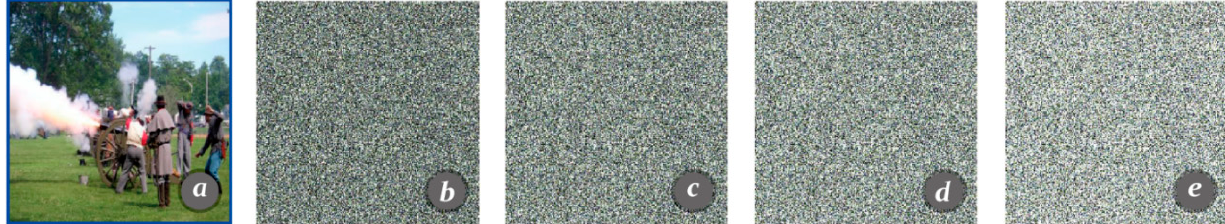
Figure 8. Illustration of noise attack. ( a ) Original image, ( b ) amplitude part of encrypted image, ( c ) encrypted image with noise weight of 0.25, ( d ) encrypted image with noise weight of 0.5, and ( e ) encrypted image with noise weight of 1. Table 8. CIDEr-score performance based on noise attack.